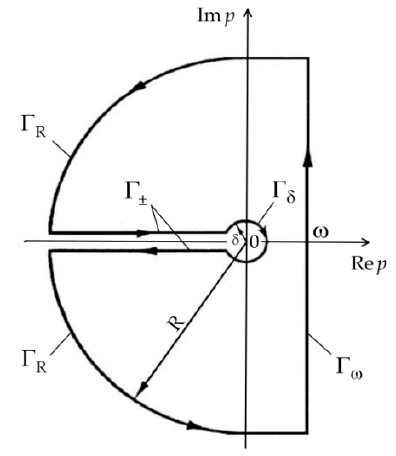
Figure 2. Integration contour.